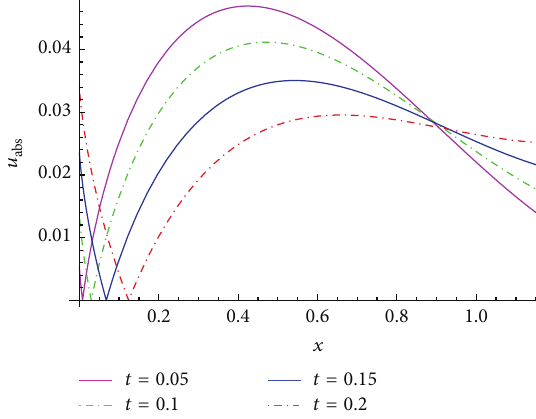
Figure 1: Comparison between the real part of 𝑢 4 and the exact solution 𝑢 .